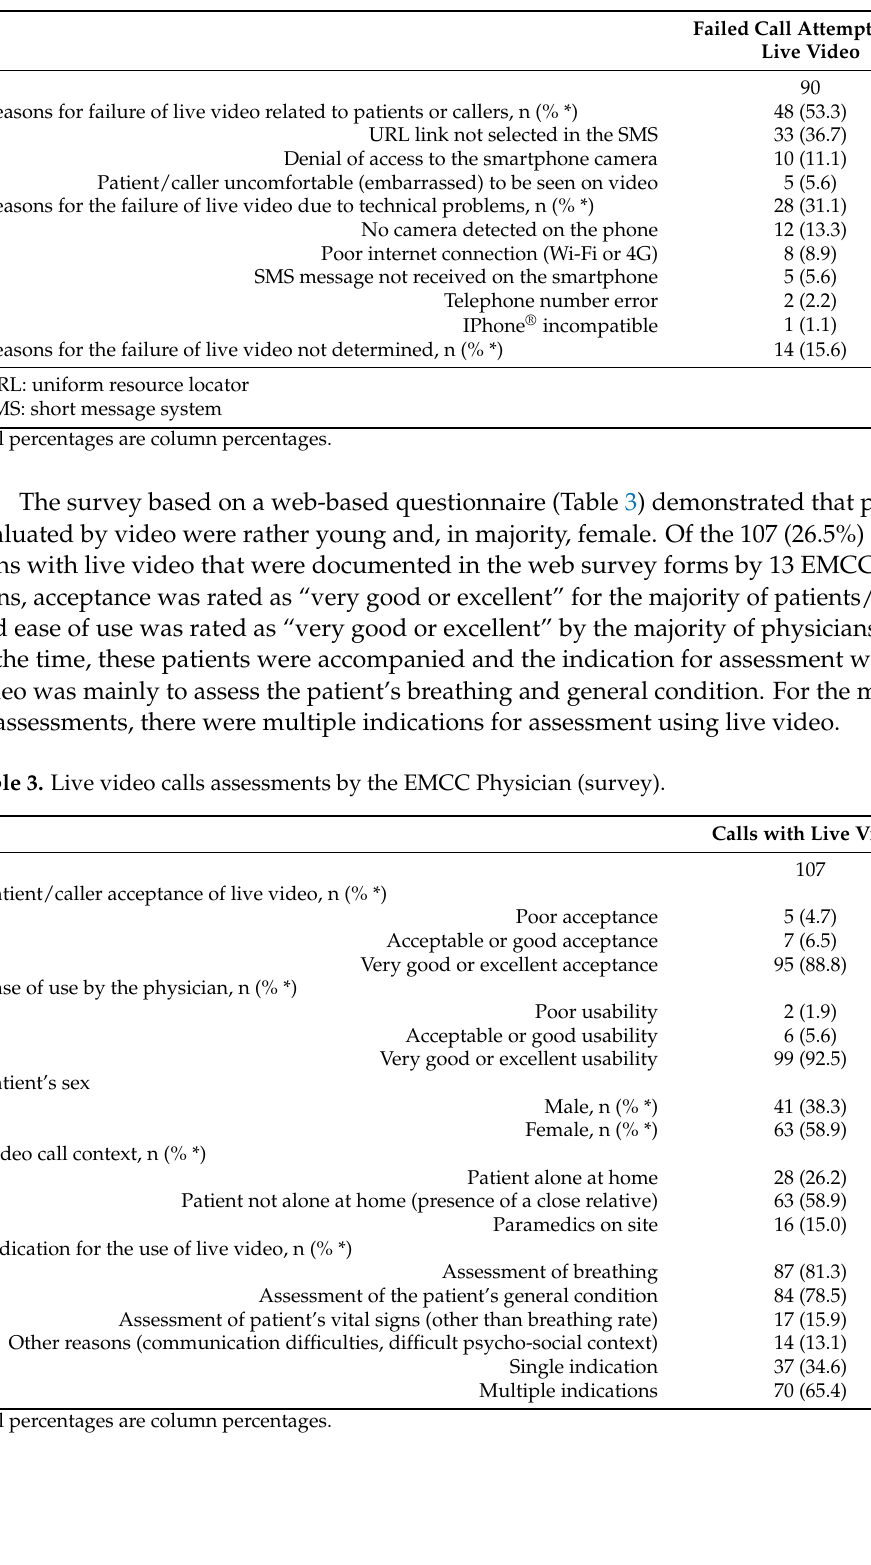
Table 2. Live video failures (data from the Instantview ® application).